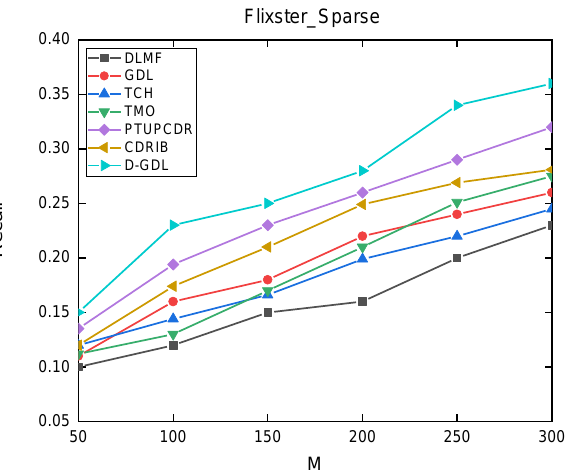
Figure A3. Performance of D-GDL against the comparative approaches based on Recall vs. M for netflix dataset in the sparse setting.